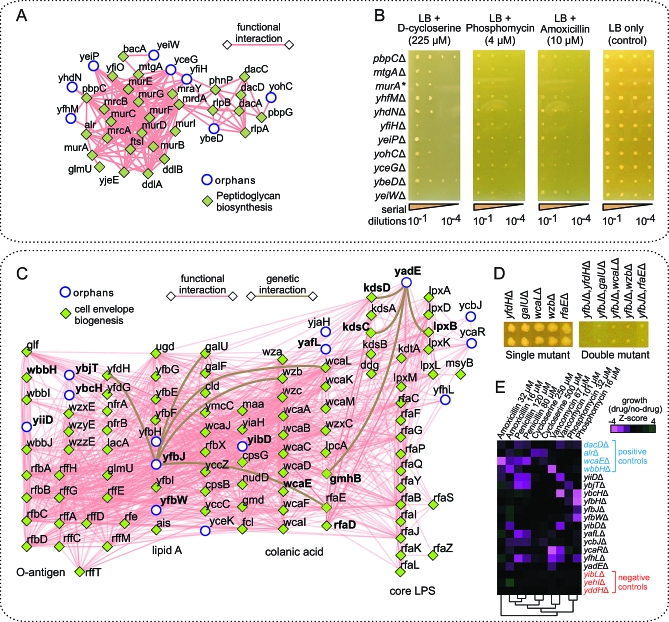
Functional Neighborhoods Involved in Cell Envelope Biogenesis(A) Functional neighborhood showing high-confidence integrated functional interactions (combined PI and GC networks) between components of the complete peptidoglycan biogenesis pathway and putatively functionally related orphans.(B) Serial-dilution assay showing perturbed growth of E. coli strains deleted for putative cell wall–related components (from [A]) in the presence of antibiotic inhibitors of cell wall assembly; an asterisk (*) indicates a hypomorphic allele of the essential gene murA.(C) Functional neighborhood of metabolic pathways involved in biogenesis of the bacterial cell envelope. Vertical groupings correspond to known pathways, whereas orphan components are tentatively positioned according to their interaction patterns; brown lines indicate aggravating genetic interactions recorded between the orphan yfbJ and yadE and annotated pathway components.(D) Conjugation-based double-mutant growth assays (only test results for yfbJ are shown).(E) Heat map showing the differential sensitivity of strains deleted for the orphans shown in (C) to antibiotics targeting the cell envelope. Mutants deleted of relevant annotated proteins are shown as positive controls, while mutants lacking genes not contained within this neighborhood are shown as negative controls.